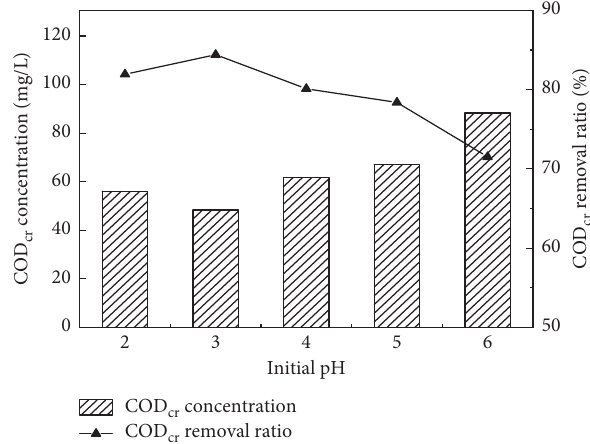
Figure 10: Effect of initial pH on CODcr removal.